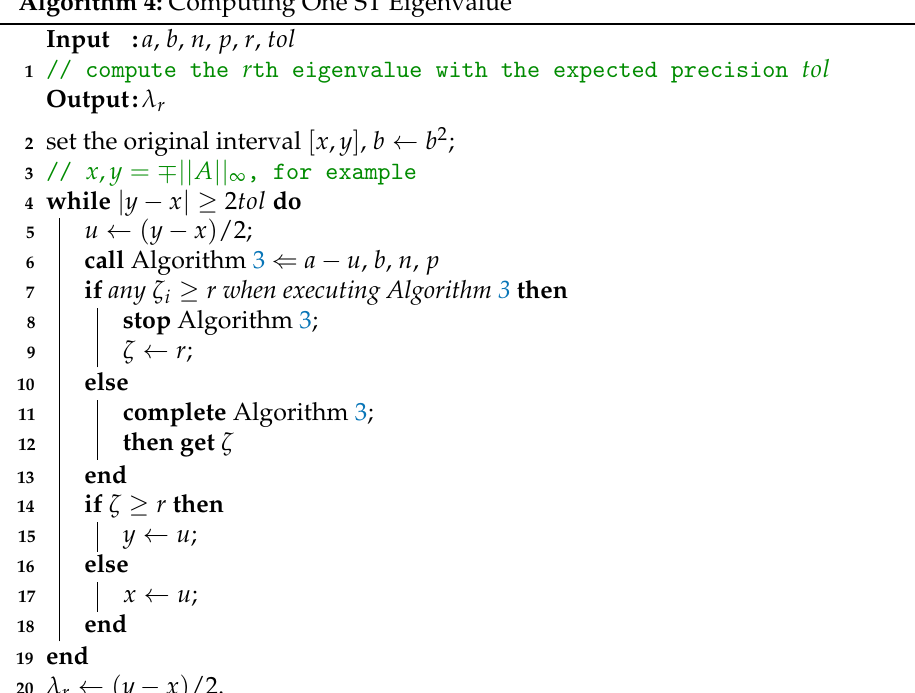
Algorithm 4: Computing One ST